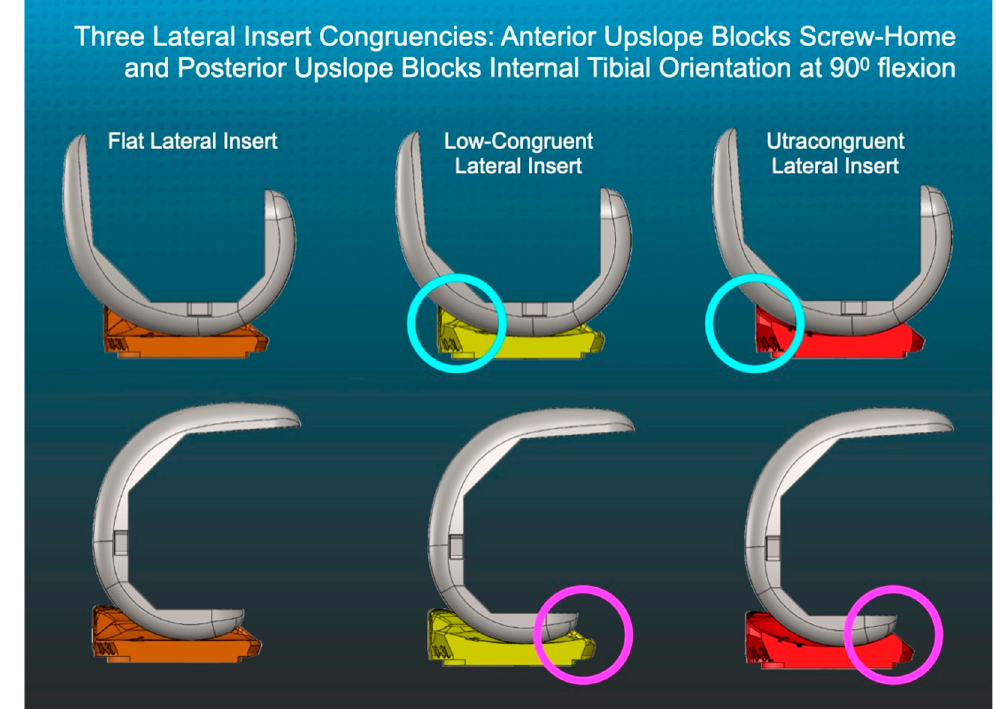
Figure 2. Schematics show the sagittal profiles of flat (F), low-congruent (LC), and ultracongruent (UC) lateral inserts relative to the femoral component with the knee in extension (top row) and at 90° flexion (bottom row).